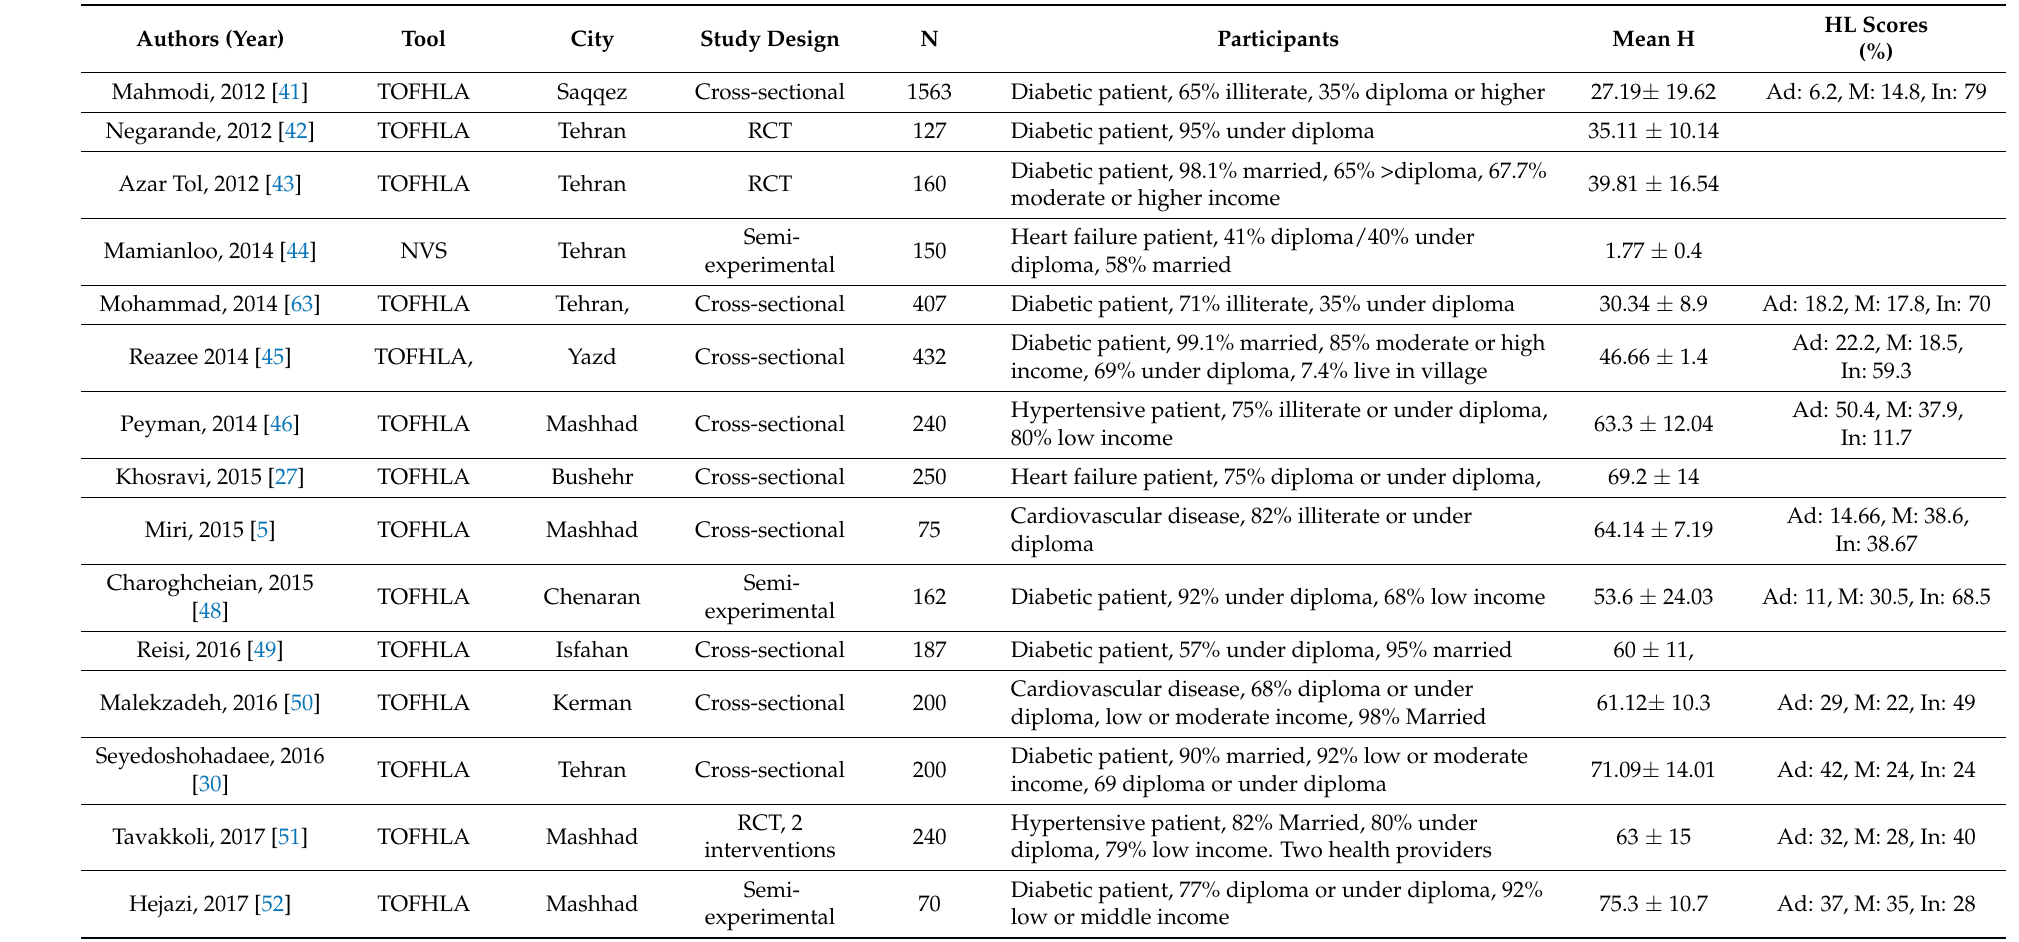
Table 1. Characteristics of included